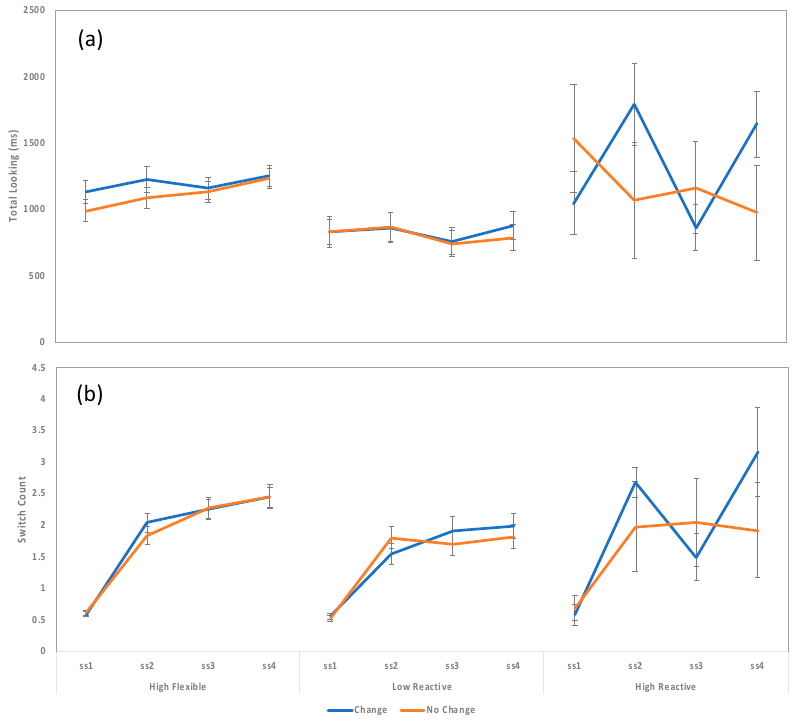
Figure 7. Mean total looking ( a ) and switch count ( b ) during the test array as a function of attention phenotype, change status and set size.